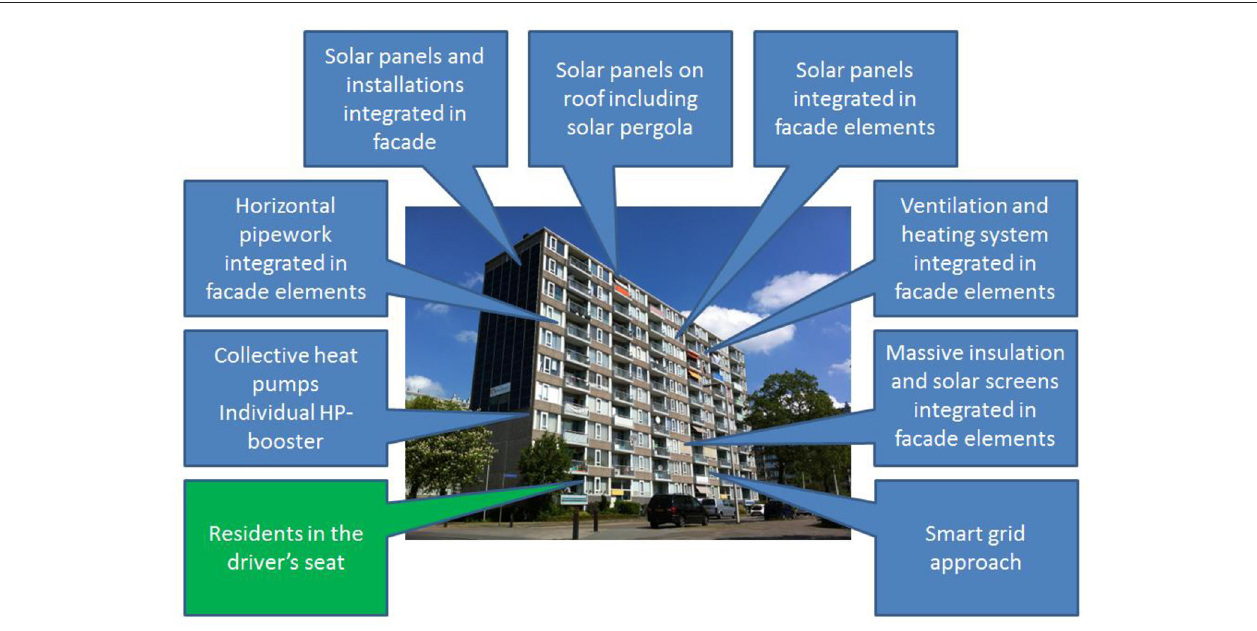
FIGURE 1 | The proposed sustainable renovation plan ( © Utrecht Sustainability